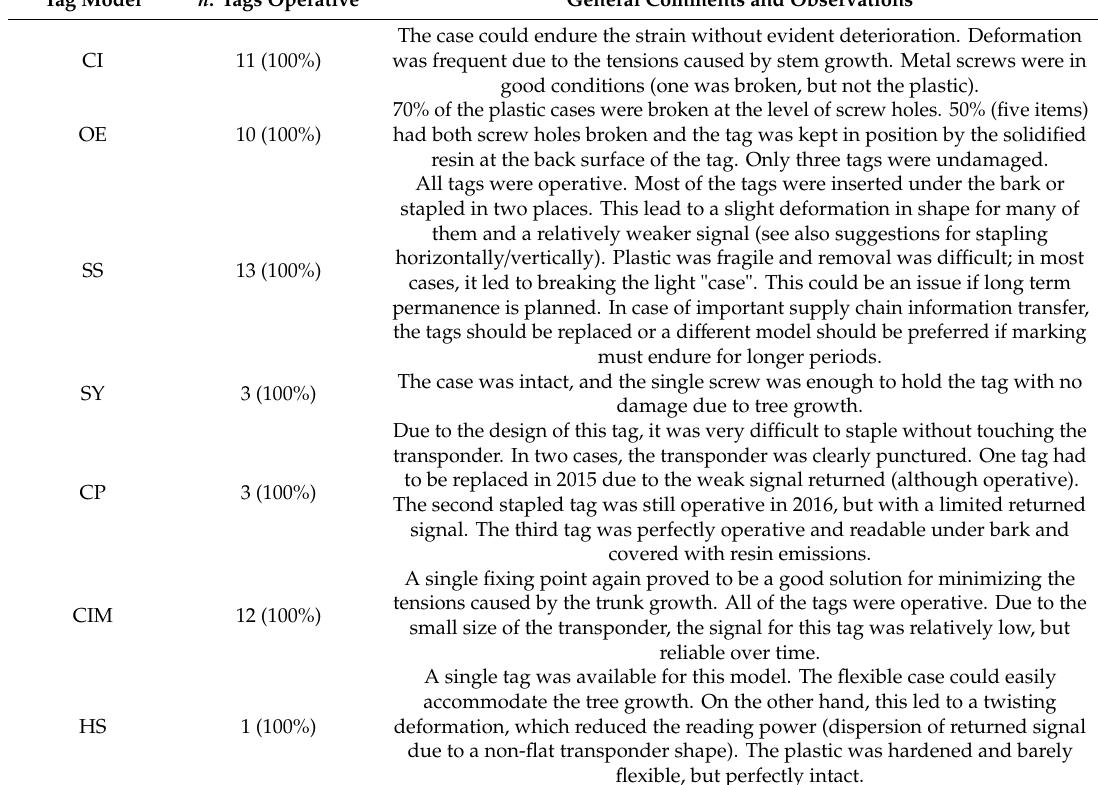
Table 4. Operative conditions and general comments of tags after 2 years permanent installation in